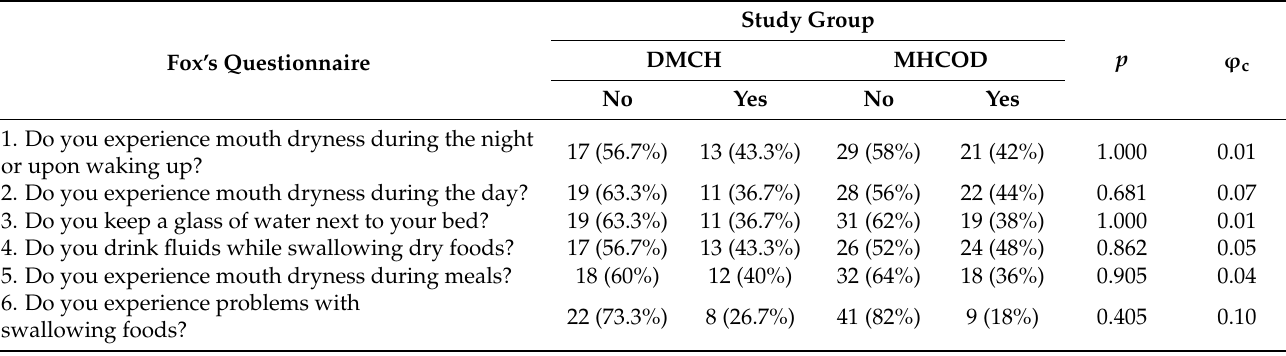
Table 8. The results of the Fox’s questionnaire in both